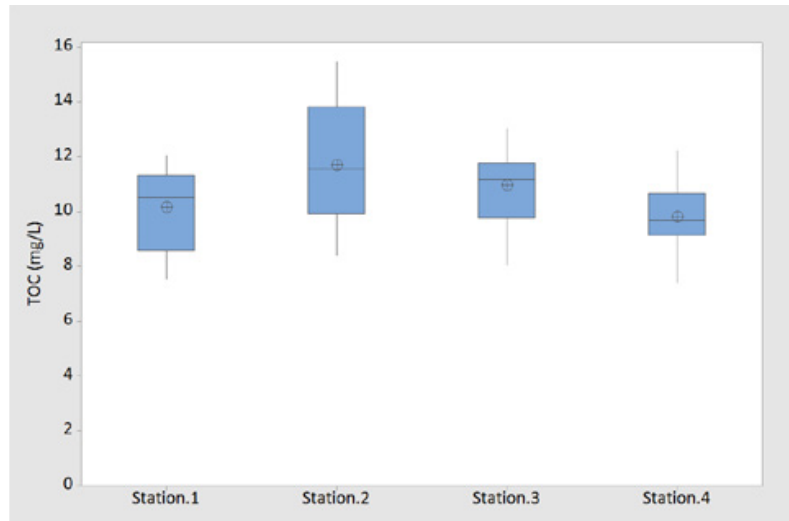
Fig. 2: The average TOC concentration in the river segment at various stations.